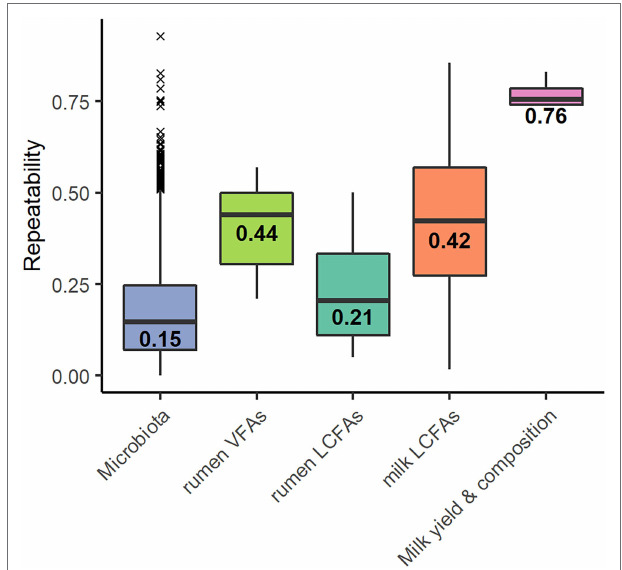
FIGURE 1 | Repeatability values of the 1,599 operational taxonomic units (OTUs)* of the microbiota, the six volatile fatty acids (rumen VFAs), the 27 rumen long-chain fatty acids* (rumen LCFAs), the 37 milk long-chain fatty acids* (milk LCFAs) and the traits milk yield, and fat content and protein content and somatic cell score (Milk yield & composition). Values indicate the median. *Repeatability values were estimated for the OTU and trait models that